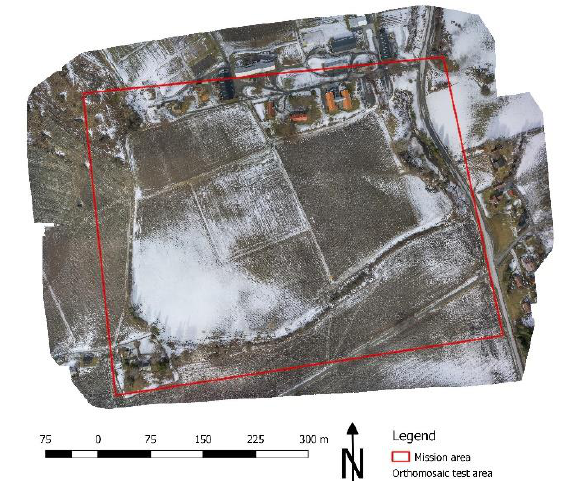
Figure 7. Orthomosaic of the test area with the outlines of the mission area in